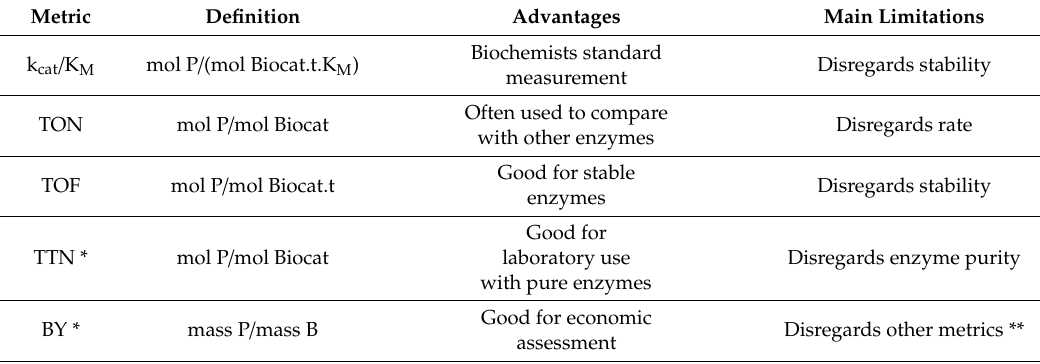
Table 1. Various reported methods of measuring biocatalyst performance. All methods are dependent upon the conditions used, and therefore, should not be quoted in isolation. * Measured over the lifetime of the biocatalyst. ** Achievable product concentration and